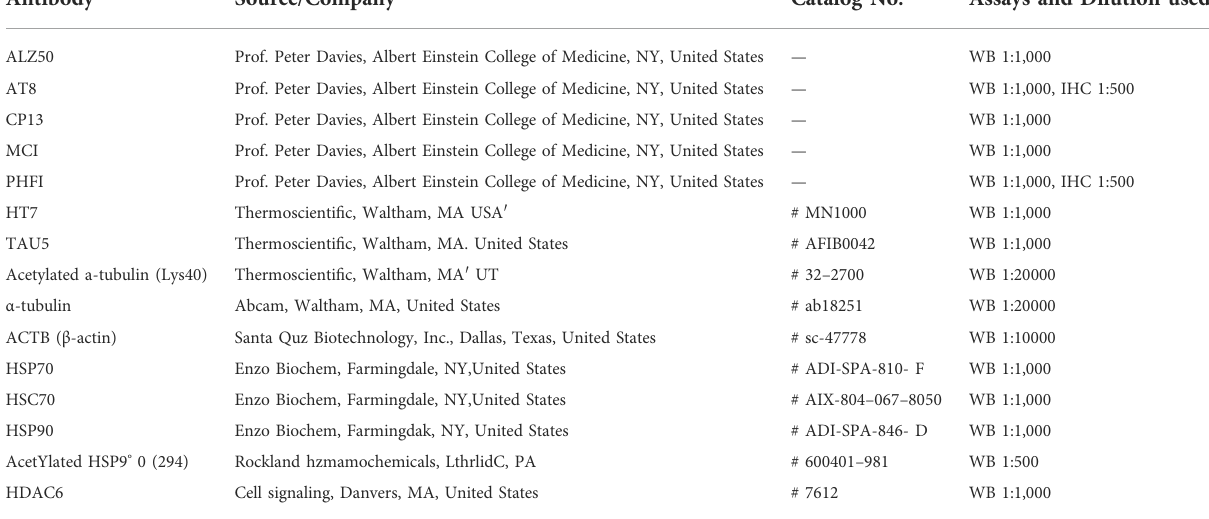
(0.1%), and blocked with BSA (2%). LAMP2A antibody